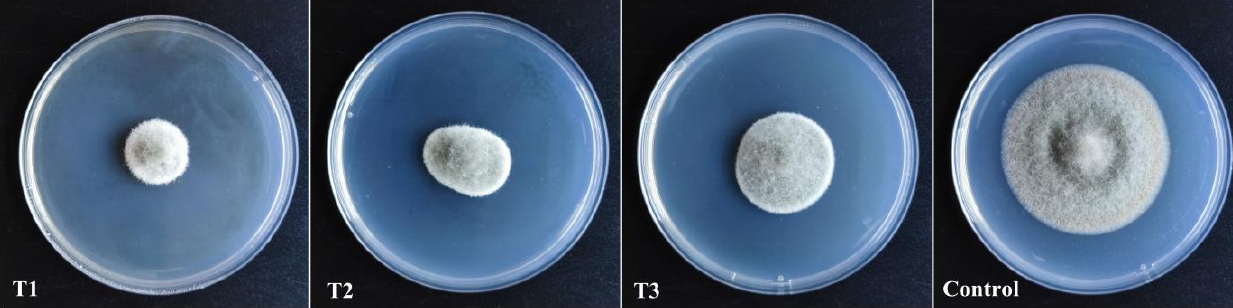
Table 2. Effect of aseptic filtrate on conidia germination of Alternaria alternata . Treatment